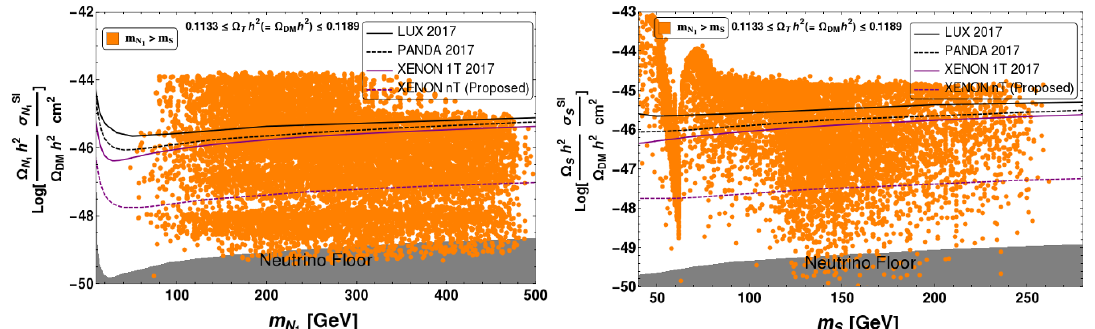
Figure 16 . Relic density allowed points plotted in DM mass vs e(cid:11)ective SI DM-nucleon cross- (cid:16) (cid:10) (cid:17) (cid:16) (cid:17) 2 (cid:10) S h 2 N 1 h section plane: (cid:27) SI m N plane (left) and (cid:27) SI m S plane (right) in presence N 1 (cid:0) S (cid:0) (cid:10) DM h 2 (cid:10) DM h 2 1 of heavy scalar S H . Upper bounds on SI DM-nucleon cross-section from LUX [9] (black solid line), recent PANDA [12] (black dashed), XENON 1T [10] (purple solid line) and predicted XENON nT [11] (purple dotted line) are also indicated in the (cid:12)gures. We have chosen the mass hierarchy: m N > m S and the mediator mass m (cid:31) = 500 GeV. 1 2